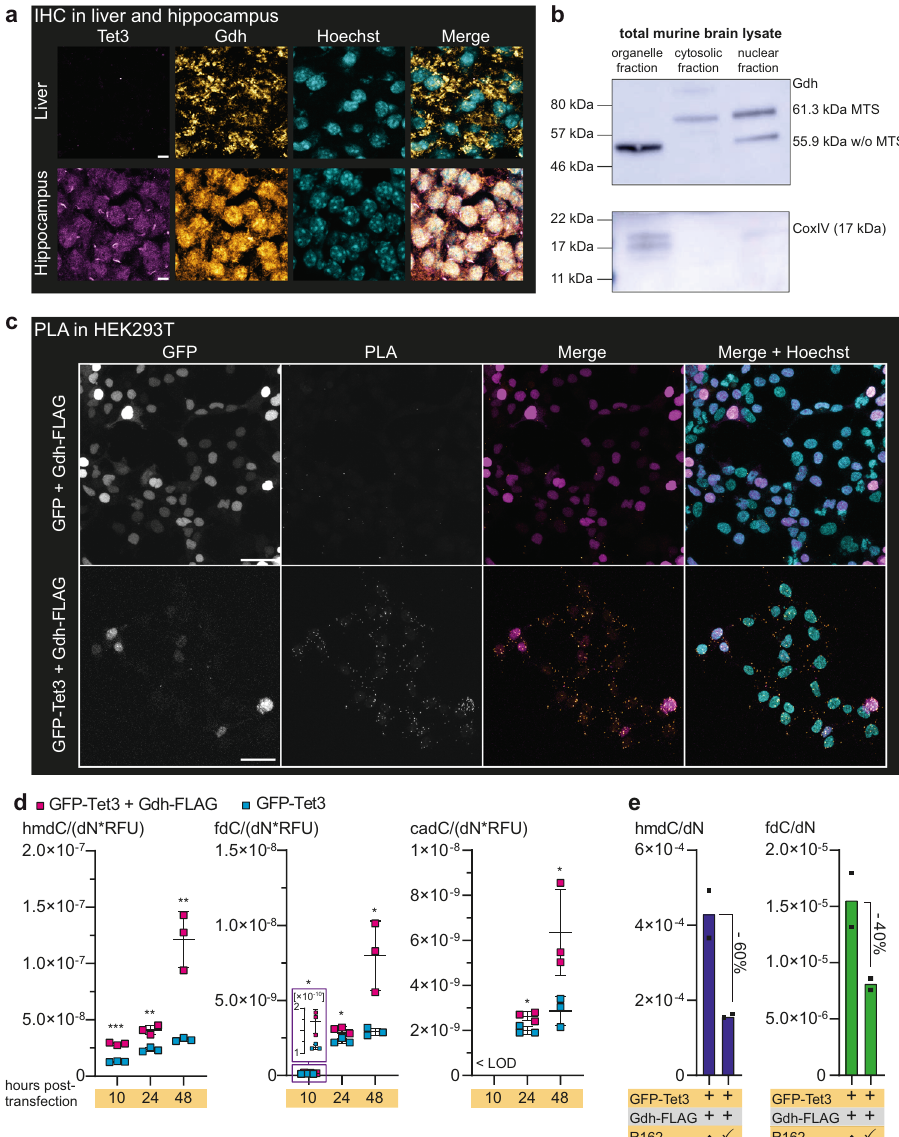
Fig. 3 Gdh localization in brain and liver and Tet3 + Gdh interaction after ectopic co-expression in HEK293T cells. a Immuno fl uorescence staining of Tet3 and Gdh in murine hippocampus compared to liver. Scale bar is 5 µ m. b Western blot to determine Gdh content of different cellular compartments (fractionation from total murine brain) shows different echoforms of Gdh. CoxIV was used as a mitochondrial marker. c PLA in HEK293T after ectopic co- expression of GFP-Tet3 and Gdh-FLAG. GFP + Gdh-FLAG co-expressing cells were used as a negative control. In the merged image, GFP signal is shown in magenta, PLA signal in orange and nuclei (cyan) were stained with Hoechst. Scale bar is 50 µ m. d Levels of hmdC, fdC, and cadC 10 h, 24 h, and 48 h after transfection of HEK293T ( n = 3 biologically independent samples for each timepoint) with either GFP-Tet3 + Gdh-FLAG expressing plasmids (magenta) or GFP-Tet3 expression plasmid and an empty vector (cyan). Levels of mdC-oxidation products were normalized to the GFP signal of the cells. For each modi fi cation, each timepoint was compared individually. Two-sided t -test, correction for multiple comparisons using Holm-Sidak method, p adj < 0.05 (*), <0.01 (**), <0.001 (***); exact p values and statistical details are provided in the Statistics and Reproducibility sub-section within the “ Methods ” section. Bars show mean, error bars show SD. LOD limit of detection e Levels of hmdC and fdC in the absence or presence of 20 µ M of Gdh inhibitor R162 24 h after transfection of HEK293T ( n = 2 biologically independent samples) with GFP-Tet3 and Gdh-FLAG expressing plasmids. a , c Images show Z-stacks. Source data are provided as a Source Data fi performed a functional assay in HEK293T cells with ectopically that GFP-Tet3 and Gdh-FLAG were in close proximity in the co-expressed murine GFP-Tet3 and C-terminally FLAG-tagged nuclei of HEK293T cells. Next, we quanti fi ed the levels of hmdC, murine Gdh (Gdh-FLAG). We fi rst veri fi ed the interaction of fdC, and cadC using our reported UHPLC-QQQ-MS method 45 at 10, 24, and 48 h post transfection in HEK293T cells that were GFP-Tet3 and Gdh-FLAG in HEK293T cells, again using a PLA either transfected with plasmids coding for GFP-Tet3 and Gdh- with anti-GFP and anti-FLAG primary antibodies (Fig. 3c). While FLAG, or with the plasmid coding for GFP-Tet3 and an empty in the negative control, where unfused GFP and Gdh-FLAG were vector. In this model system, glutamate supply was guaranteed by co-expressed, no PLA signal was detectable, co-expression of the addition of 2 mM of L -alanyl-glutamine to the medium. To GFP-Tet3 and Gdh-FLAG provided clear PLA signals, indicating